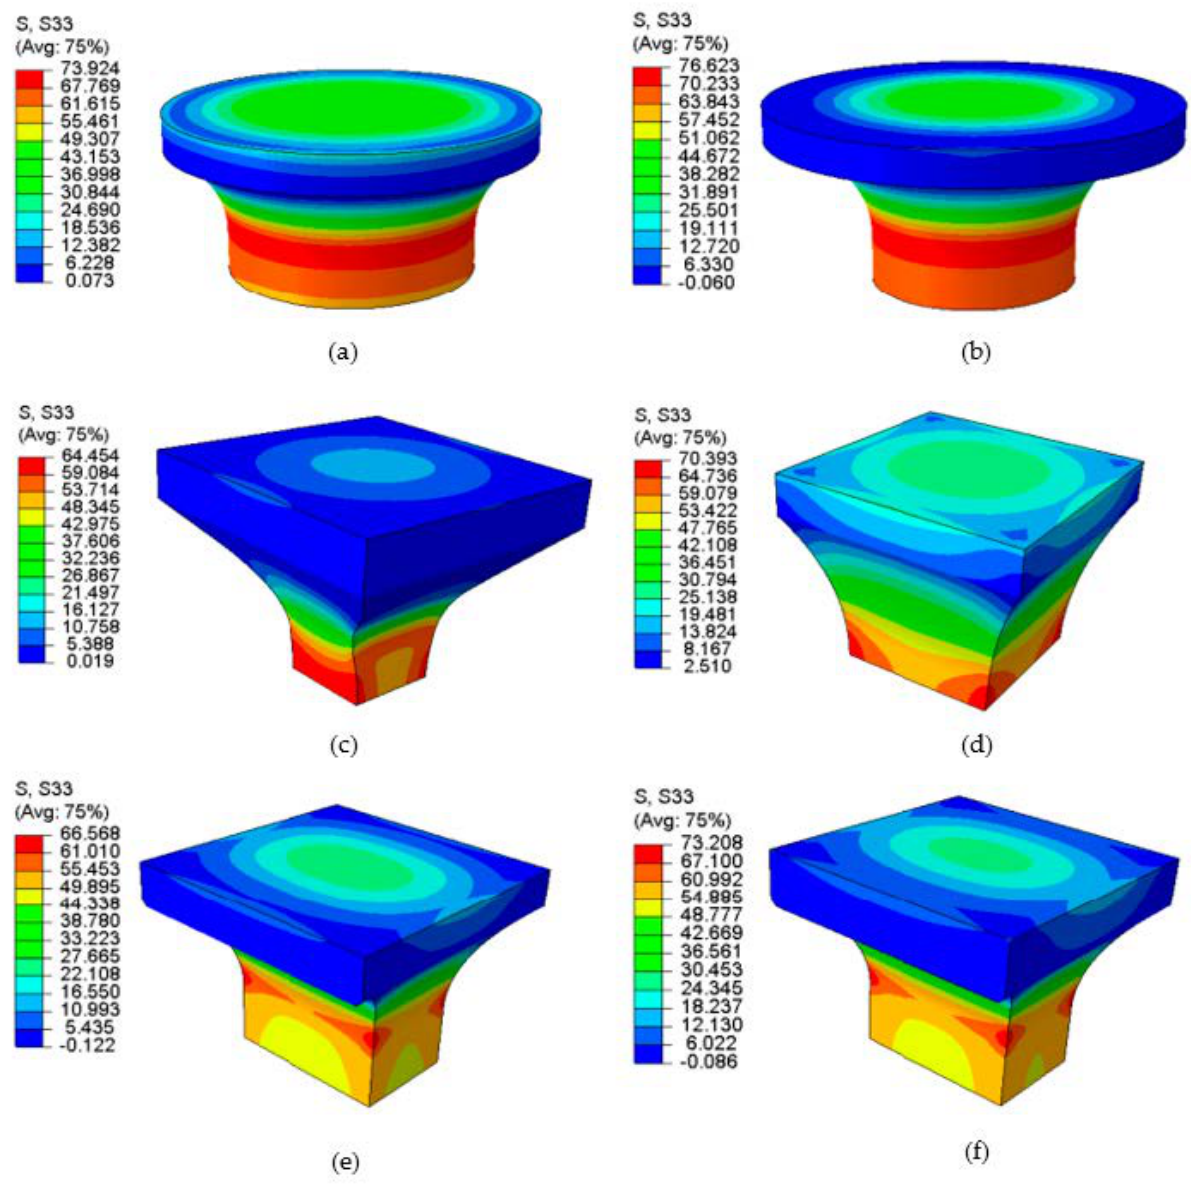
Figure 14. Stress contour plots for ( a ) spool A, ( b ) spool B, ( c ) bi-lateral waist, ( d ) RARDE Type II, ( e ) RARDE Type III, and ( f ) RARDE Type III (mini)